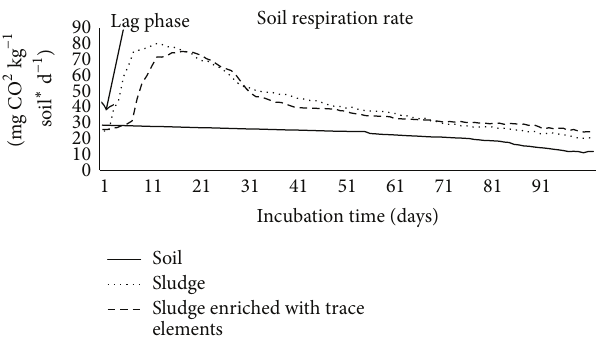
Figure 3: Typical respiration trends of soils amended with sewage sludge enriched or not with trace elements (Cd 12mgkg −1 , Zn 300 mg kg −1 ). A lag phase can be observed before the onset of the C flush for metal spiked